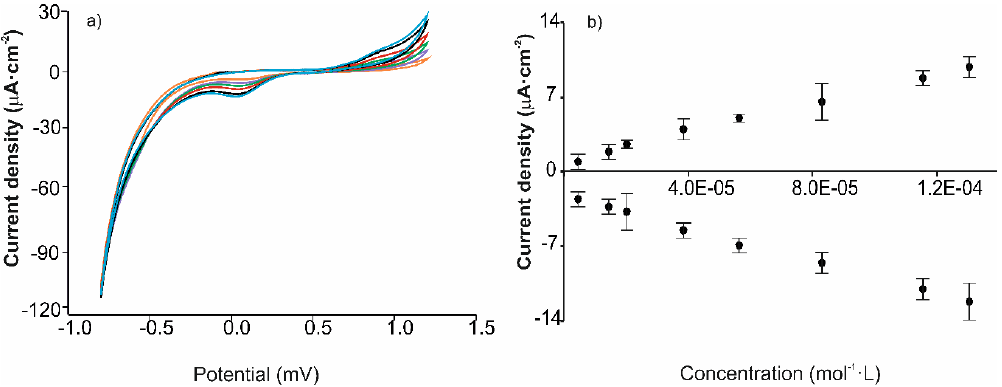
Figure 7. Analysis of limits of detection. ( a ) Voltammetric response of the AuNP tOcBr /ZnPc AcS sensor to increasing concentrations of catechol (from 4 × 10 − 6 to 1.40 × 10 − 4 mol∙L − 1 in phosphate buffer), ( b ) calibration curves calculated in both the anodic and the cathodic peaks.